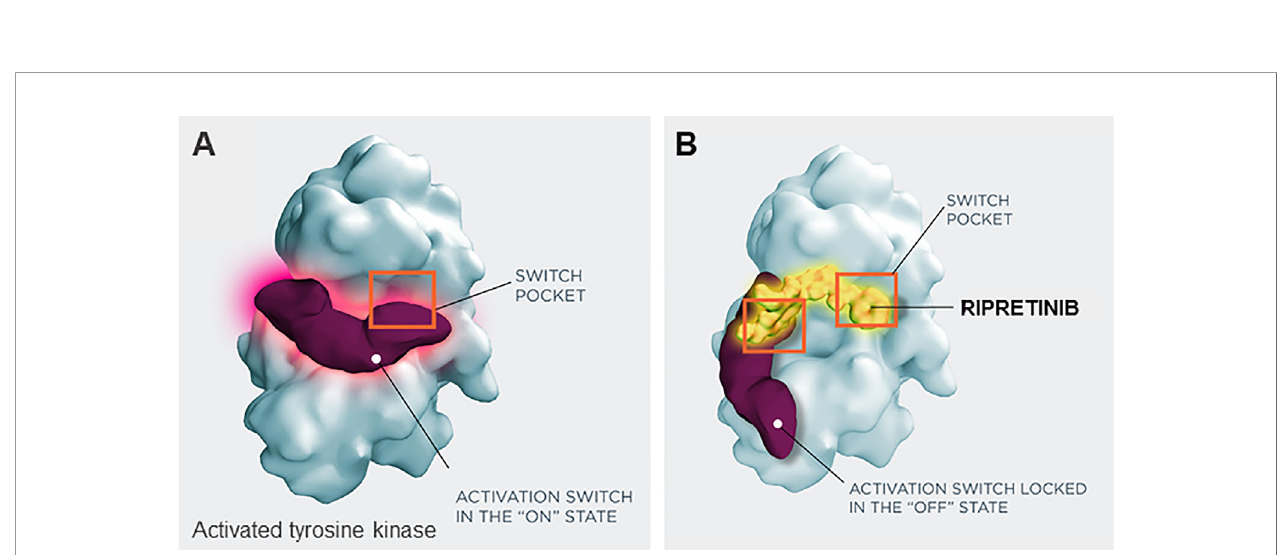
FIGURE 2 | Switch control inhibition by ripretinib. (A) Activated tyrosine kinase, (B) inactivated tryosine kinase, with ripretinib. Ripretinib uses a dual mechanism of action that secures the kinase into an inactive con fi rmation and prevents downstream signaling by binding both the switch-pocket region and the activation switch.